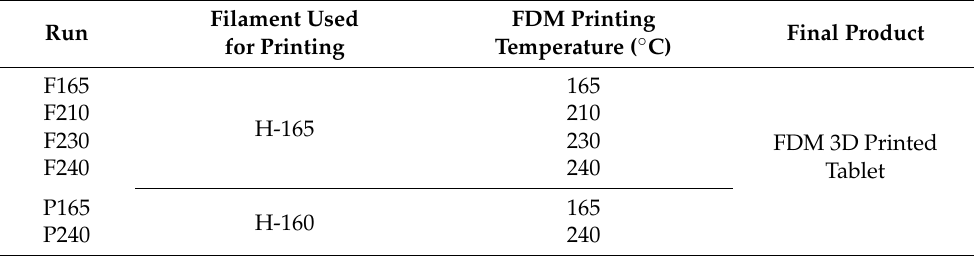
Table 2. FDM 3D processing temperatures for GF-loaded and placebo tablets.